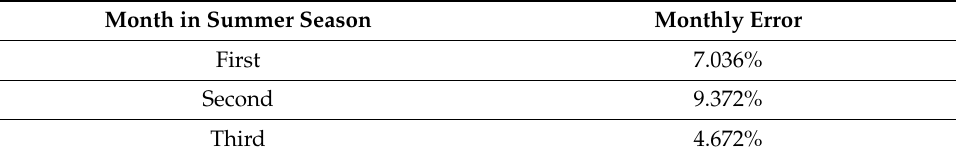
Table 3. Average monthly errors.